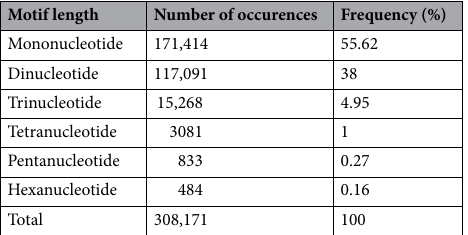
Table 4. Microsatellite abundance in C. oblonga genome